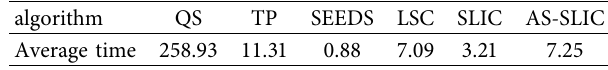
Table 1: Average time of algorithm. algorithm QS